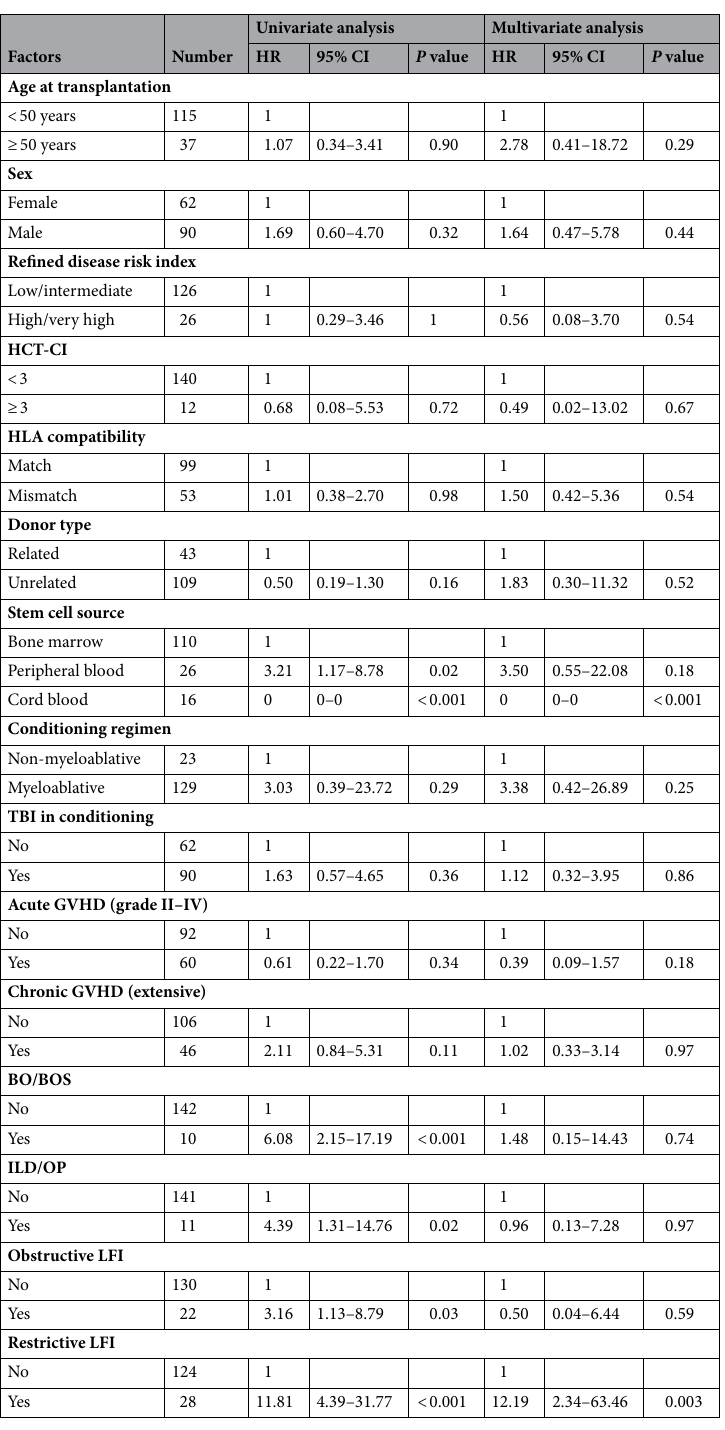
Table 4. Characteristics of the patients and factors associated with non-relapse mortality. HR hazard ratio, CI confidence interval, HCT-CI Hematopoietic Cell Transplantation Comorbidity Index, HLA human leukocyte antigen, Inf infinite, TBI total body irradiation, GVHD graft-versus-host disease, BO bronchiolitis obliterans, BOS bronchiolitis obliterans syndrome, ILD interstitial lung disease, OP organizing pneumonia, LFI lung function